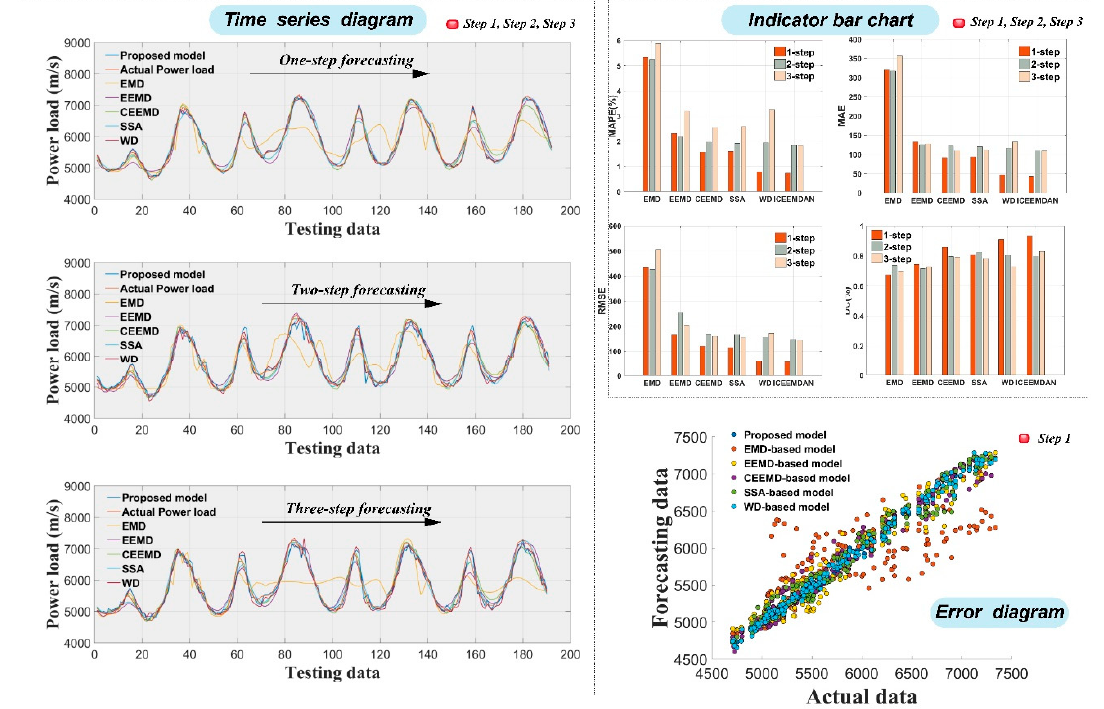
Figure 5. The multi-step forecast ability in Experiment II for site 2. The picture is divided into three parts: one to three steps time series forecasting chart, three steps error comparison bar chart and one-step forecasting error point chart.